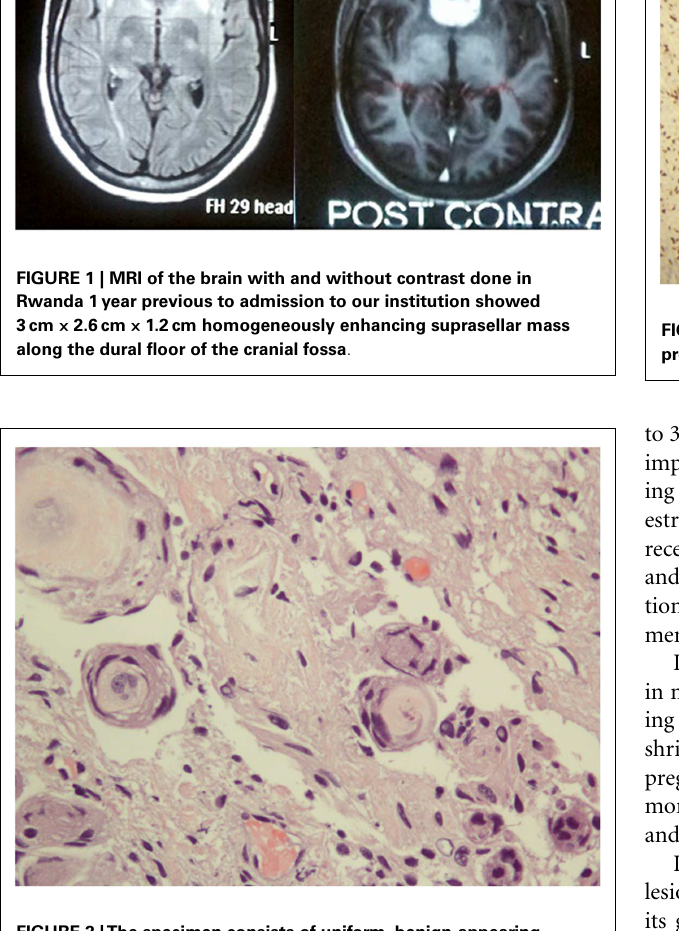
tentorium cerebelli, pineal region, optic nerve, and foramen magnum (5).